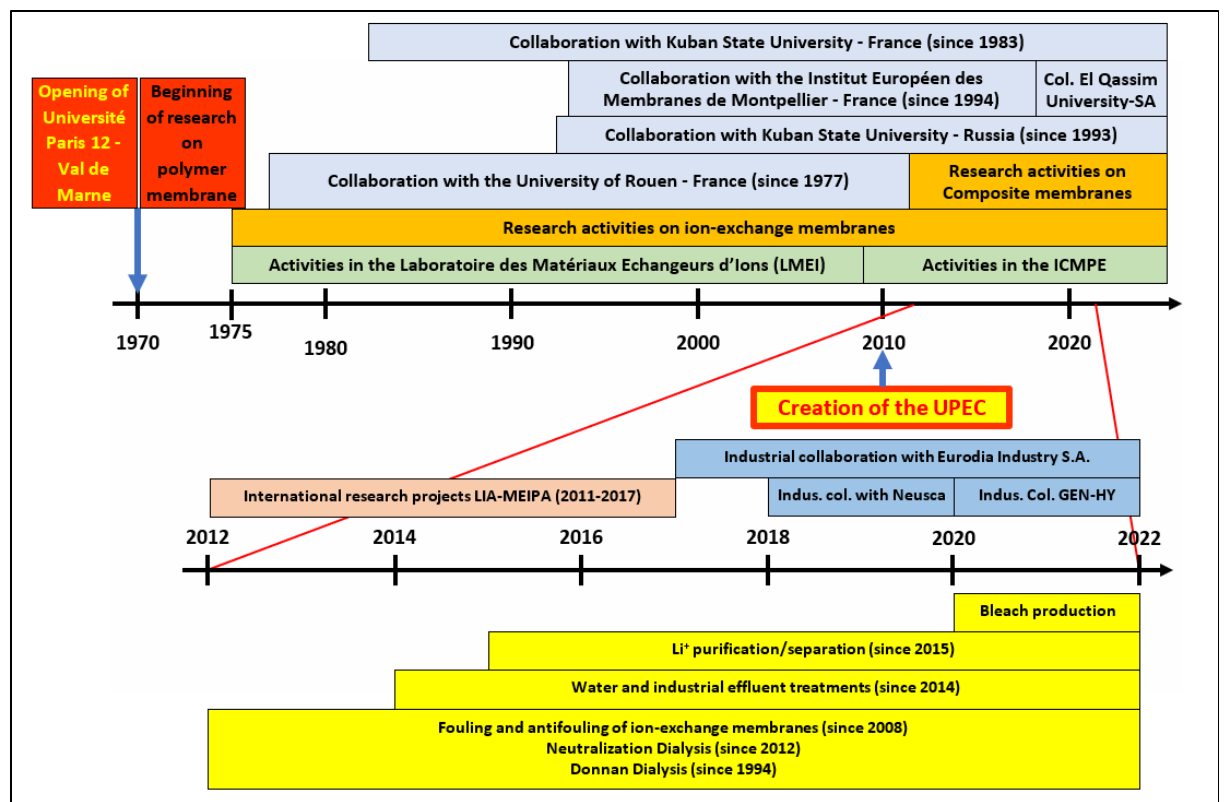
Scheme 1. Diagram illustrating the main dates, research themes and institutional and industrial collaborations of the polymer membrane activities at UPEC.